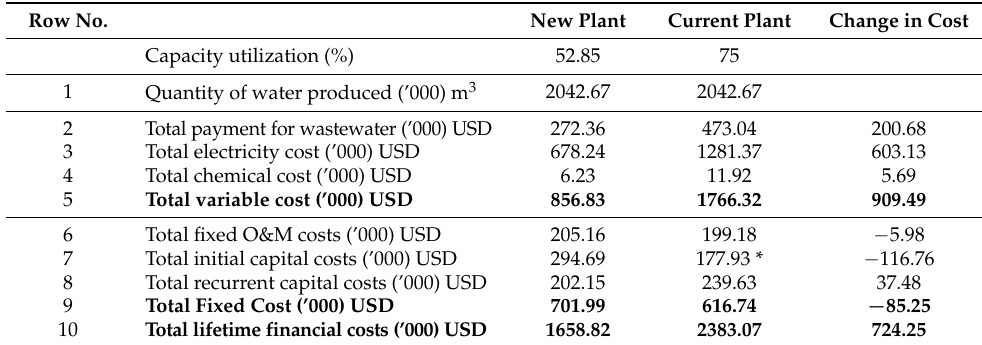
Table 3. Present value of the financial output and costs in terms of equal production in the two plants, in 2022